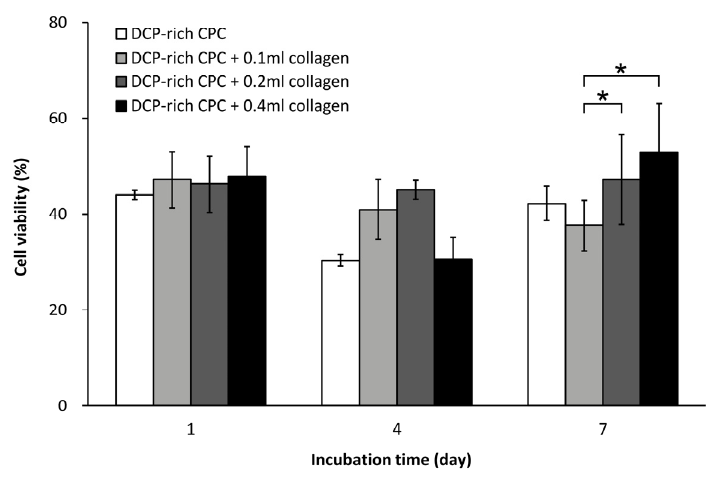
Figure 1. Cell viability of D1 cells seeded on different DCP-rich CPC samples after days 1, 4, and 7 of incubation ( n = 3). * p < 0.05.